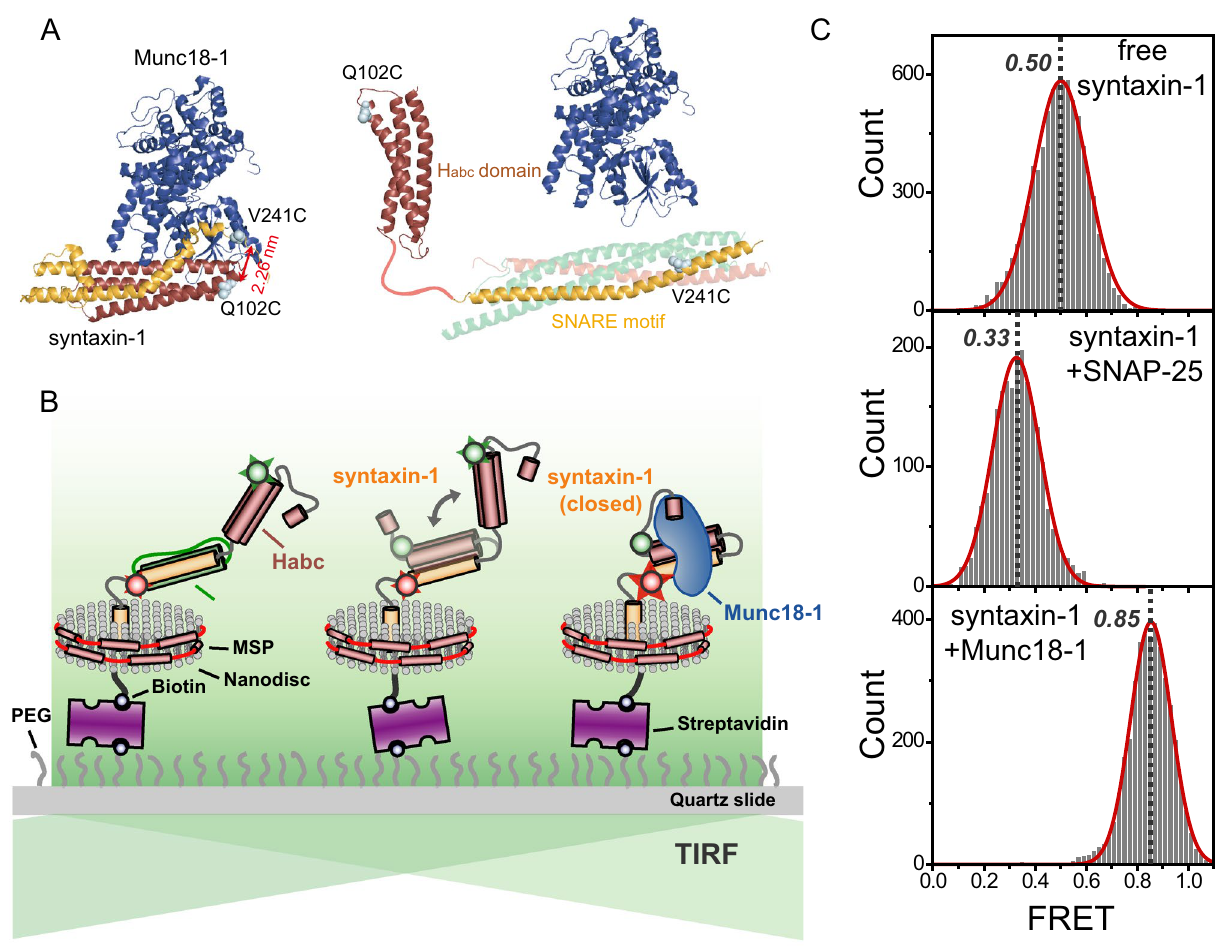
Figure 1. Single-molecule FRET measurement of syntaxin-1 conformations in t-SNARE complex formation. ( A ) Structures of the Munc18-1/syntaxin-1 complex (Protein Data Bank code 3C98) and the SNAREs (Protein Data Bank codes 1SFC for SNARE complex and 1BR0 for H abc domain). The two cysteine mutations, Q102C and V241C, introduced for site-specific dye labeling are indicated. The distance between the Cα atoms of these residues in the Munc18-1/syntaxin-1 complex was estimated to be 2.26-nm. ( B ) Schematic diagram of single- molecule FRET assay with membrane reconstitution of syntaxin-1. ( C ) FRET histograms for syntaxin-1 proteins (free syntaxin-1 only, top; with bound SNAP-25, middle; with bound Munc18-1, bottom). FRET values for each construct were obtained by fitting the FRET histograms to a single Gaussian function. To obtain the FRET histograms, all data points for each construct were collected from at least more than 50 time